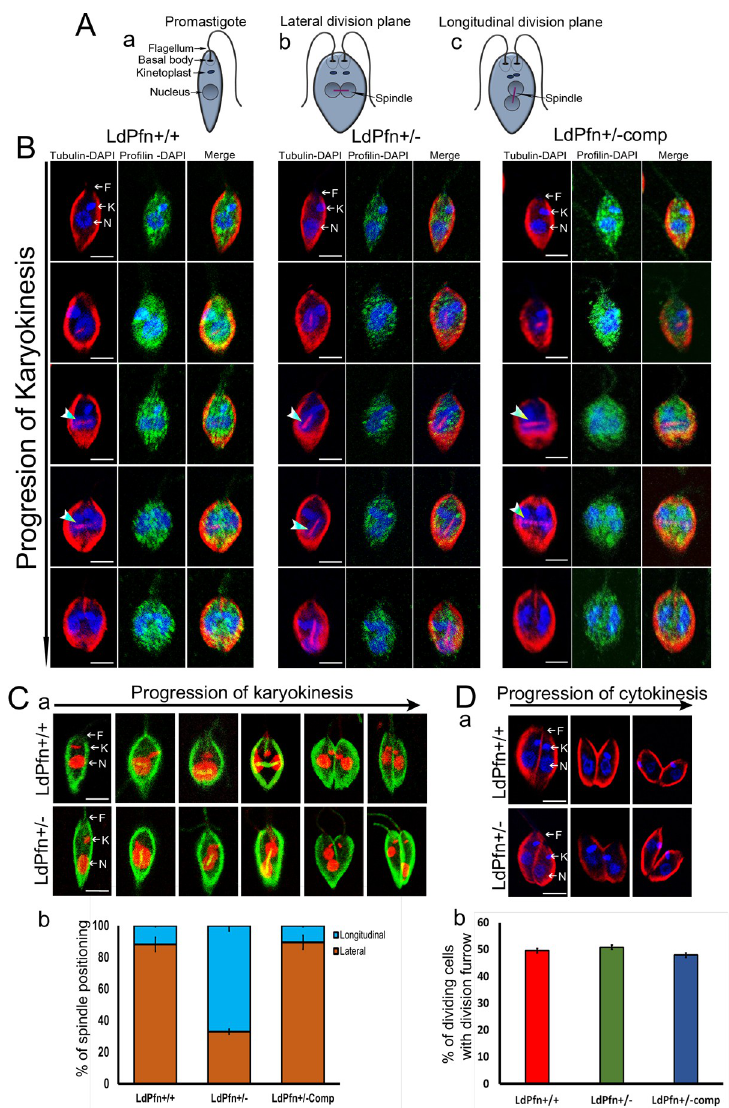
Fig 6. (A) Schematic representation of L . donovani (a) Promastigote (b) The plane of the nuclear division during karyokinesis when positioned parallel to the flagellar base in promastigote, lead to the formation of a laterally arranged spindle between the two dividing nuclei. (c) The plane of the nuclear division during karyokinesis when positioned perpendicular to the flagellar base in promastigote, lead to the formation of a longitudinally arranged spindle between the two dividing nuclei. (B) Representative immunofluorescence images of cell division pattern in LdPfn +/+ , LdPfn +/- and LdPfn +/-comp cells. The cells were stained with anti-tubulin (red) and anti-LdPfn (green) antibodies and DAPI (blue). Analysis of dividing cells revealed that the plane of the nuclear division during karyokinesis in the LdPfn +/+ and LdPfn +/-comp cells was positioned parallel to the flagellar base, leading to the formation of laterally arranged spindle between the two dividing nuclei. In contrast, in the LdPfn +/- cells the dividing nuclei were arranged nearly perpendicular to the flagellar base, leading to a longitudinally formed mitotic spindle. Scale: 2 μ m; F, Flagellar base; K, Kinetoplast; N, Nucleus. (C) (a) The cells were alternately labelled with tubulin (green) and the nucleus and the kinetoplast with propidium iodide (red). In this case also, the nuclei division plane orientation in dividing LdPfn +/- cells was altered, as compared to dividing LdPfn +/+ cells. Scale: 2 μ m. F, Flagellar base; K, Kinetoplast; N, Nucleus. (b ) Quantification of the spindle positioning (lateral or longitudinal) in the dividing cells. Percentage of cells showing laterally positioned or longitudinally positioned mitotic spindle, as quantified after labelling the cells with tubulin. Significant number of LdPfn +/- cells (n = 140) possessed nearly longitudinally positioned spindle, while LdPfn +/+ (n = 152) and LdPfn +/- comp (n = 146) cells possessed laterally positioned spindle. p-value: 0.0002. (D) Representative fluorescence images of division furrow in LdPfn +/+ and LdPfn +/- cells. (a) The cells were labelled with tubulin (red) and the nucleus and kinetoplast with DAPI (blue) for analysis of cells undergoing cytokinesis. Scale: 2 μ m; F, Flagellar base; K, Kinetoplast; N, Nucleus. (b) No significant difference was observed in the percent of dividing cells with